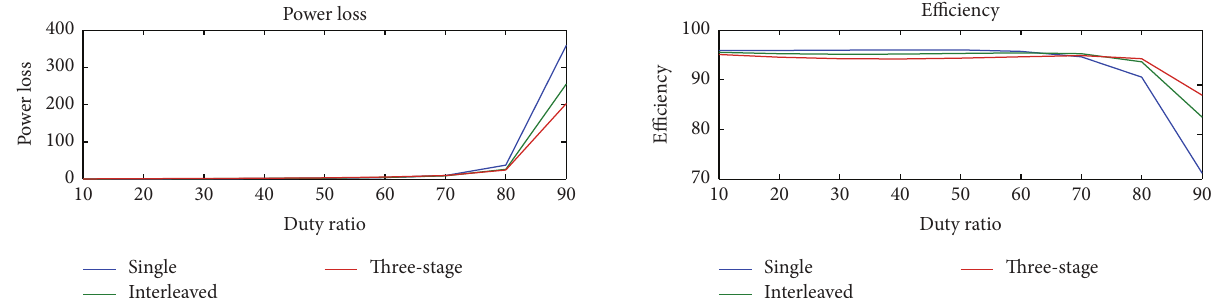
Figure 14: Comparison of performance parameters of single, interleaved, and three-stage converters for varying duty ratio.